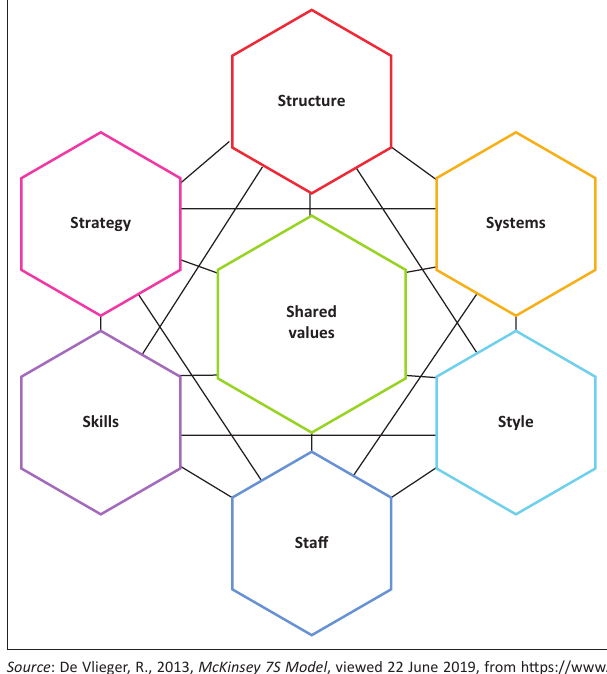
FIGURE 1: The seven elements of the McKinsey 7S model